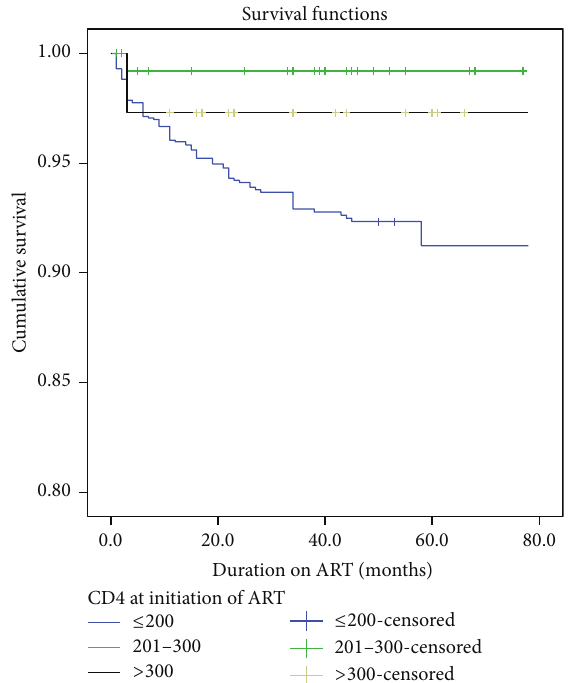
Figure 2: Survival function stratified according to initial recorded CD4countamongacohortofARTclients,GobaHospital,Southeast Ethiopia, 2013.